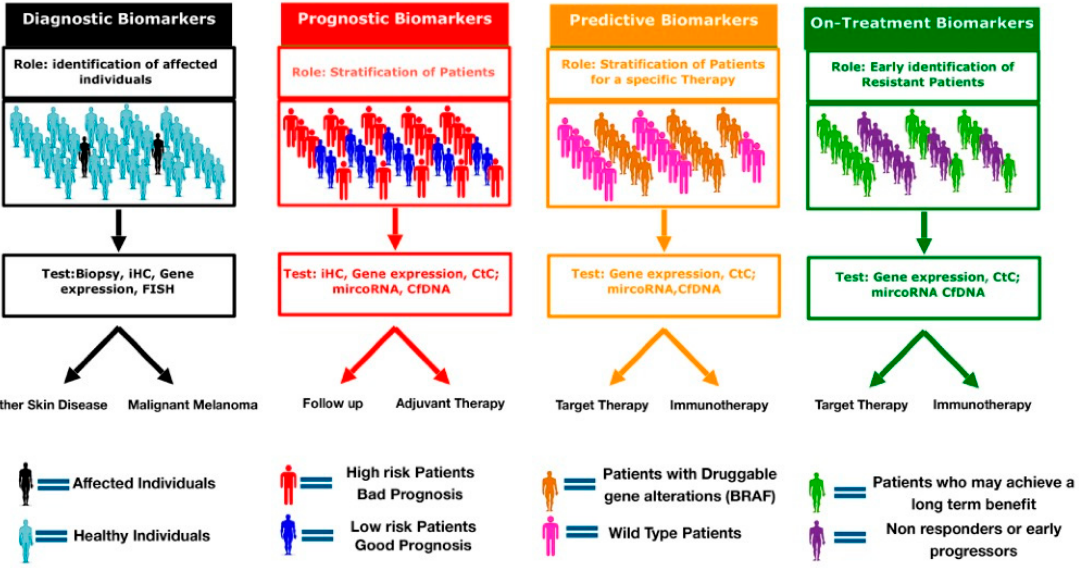
Figure 1. Clinical applications of cancer biomarkers. Genetic, protein and cellular components can serve as diagnostic, prognostic, predictive and / or on-treatment biomarkers. diagnostic biomarker are used identify and detect the presence of cancer in individuals. Prognostic biomarkers provide information on the risk of recurrence and expected outcomes. Predictive biomarkers forecast the potential benefit of a specific treatment. On-treatment biomarker help to identify early progressors from long responders.